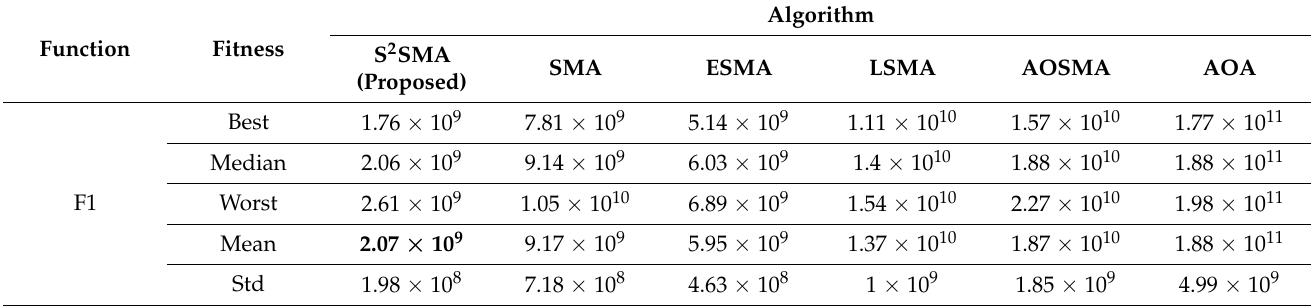
Table 4. Results of 1000-D CEC’2010 large-scale